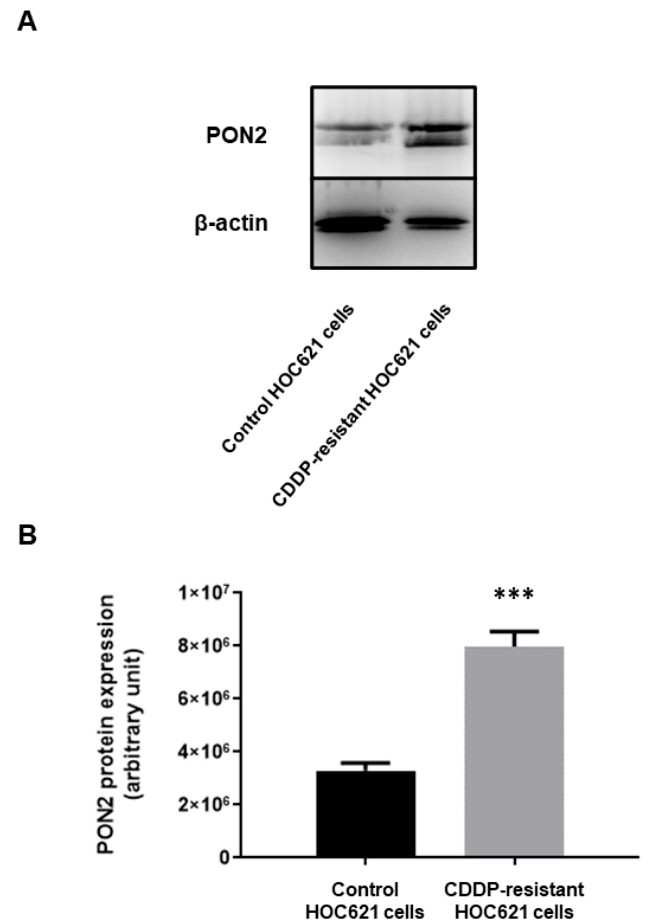
Figure 7. Western blot analysis of PON2 expression in control and CDDP-resistant HOC621 cells. Figure 7 . Western blot analysis of PON2 expression in control and CDDP ‒ resistant HOC621 cells. Aliquots (20 µ g) of protein extract were subjected to 12.5% SDS-PAGE and transferred to polyvinyli- Aliquots (20 μ g) of protein extract were subjected to 12.5% SDS ‐ PAGE and transferred to dene fluoride membrane. Blots were probed with rabbit anti-PON2 or anti- β -actin antibodies, and polyvinylidene fluoride membrane. Blots were probed with rabbit anti ‐ PON2 or anti ‐β‐ actin analyzed with chemiluminescence ( A ). Densitometry was subsequently used to evaluate signal inten- antibodies, and analyzed with chemiluminescence ( A ). Densitometry was subsequently used to sity of chemiluminescent bands and statistical analysis was performed to compare PON2 expression evaluate signal intensity of chemiluminescent bands and statistical analysis was performed to levels between chemo-resistant and parental cells ( B ). Values are expressed as mean ± standard compare PON2 expression levels between chemo ‐ resistant and parental cells ( B ). Values are expressed as mean ± standard deviation (*** p < 0.005). deviation (*** p <